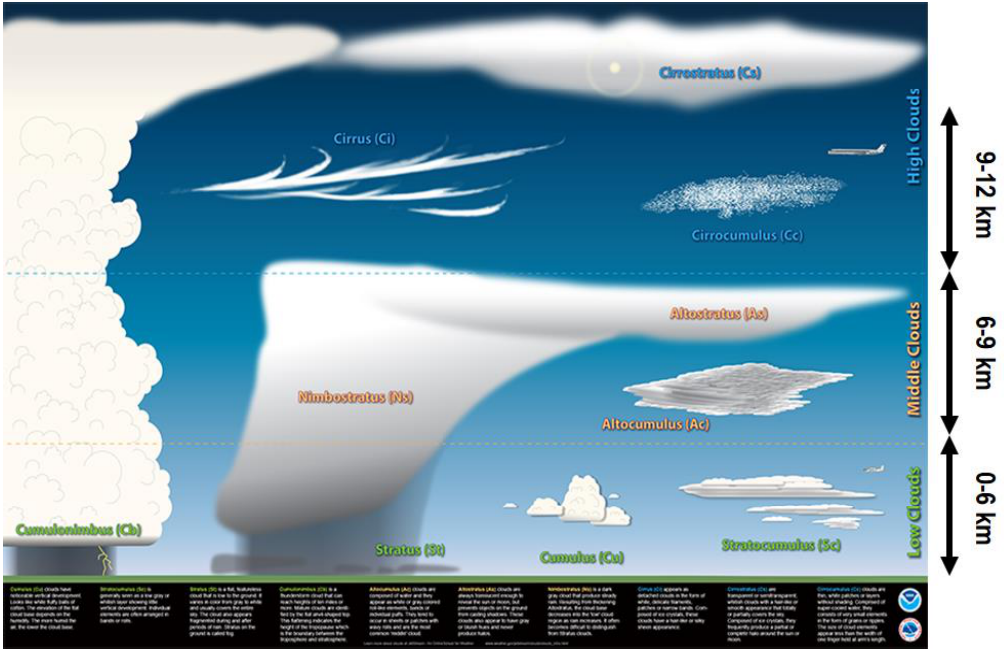
Figure 13. Cloud classification according to the U.S. National Weather Service adapted from [164].